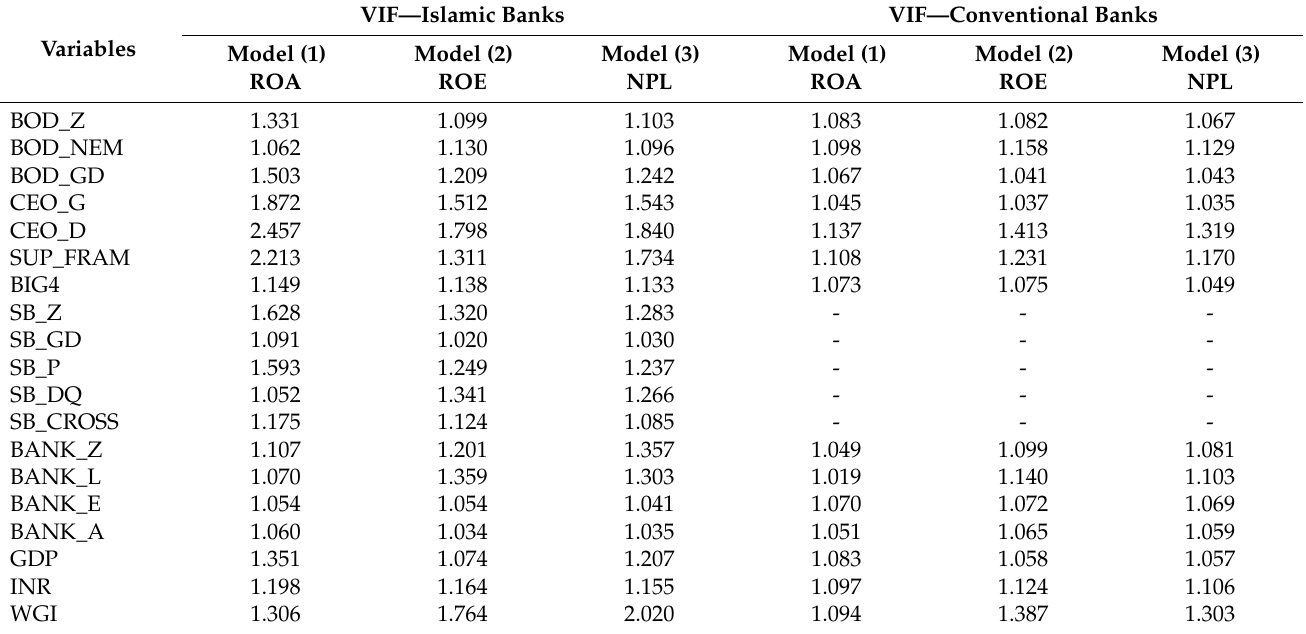
Table A3. Test of Multicollinearity.